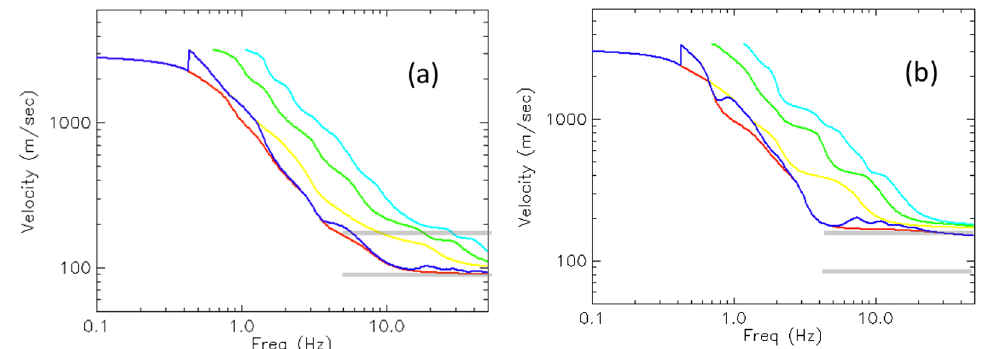
Fig. 4 a Model dispersion curves for Rayleigh mode computed for the blind project committee’s Preferred layered-earth model. Red, yellow, green, blue are modes R 0 , R 1 , R 2 , R 3 . Blue is the effective mode R e . b Model dispersion curves computed for the best-fit model described in this paper, as listed in Table 1. Horizontal grey lines indicate the discrepancy between the two sets of dispersion curves for frequencies 5–40